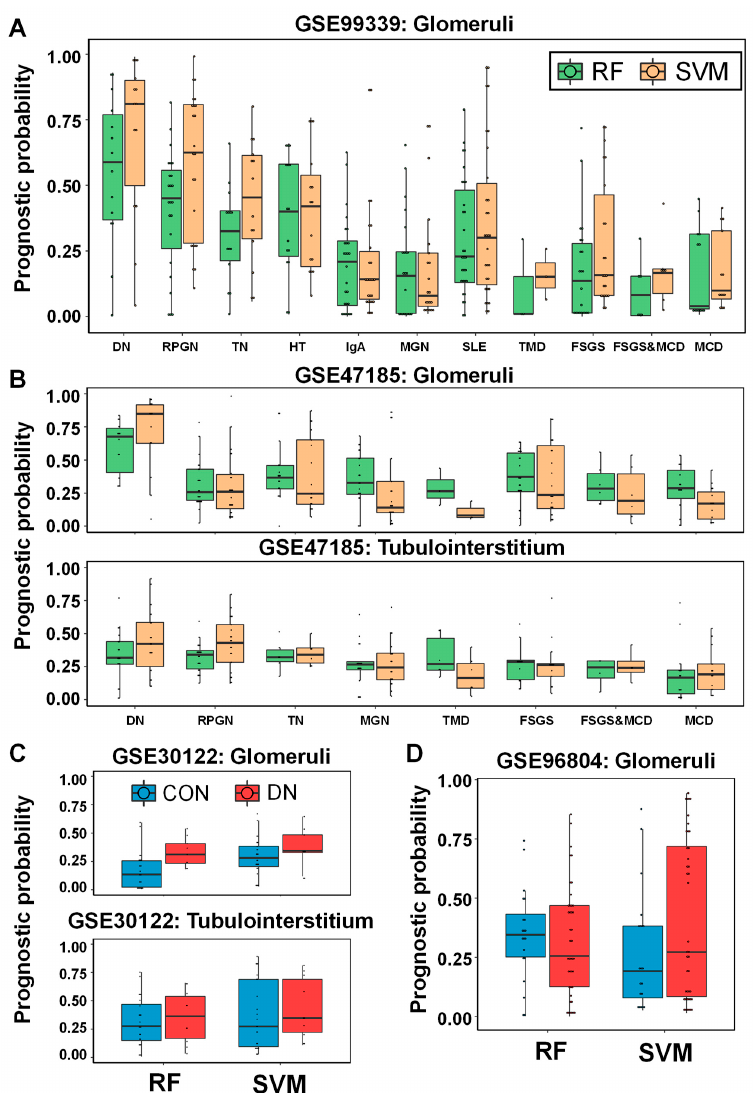
Figure 7. External validation of RF and SVM clinical models in public four GEO datasets (GSE99339, GSE47185, GSE30122 and GSE96804). ( A ) In the GSE99339 dataset, boxplot of the prognostic probabilities of the two classifiers in 11 disease groups including DN ( N = 14), RPGN ( N = 23), TN ( N = 14), HT ( N = 15), IgA nephropathy ( N = 26), MGN ( N = 21), SLE ( N = 30), TMD ( N = 3), FSGS ( N = 22), FSGS&MCD ( N = 6), and MCD ( N = 13). ( B ) In the GSE30122 data set, the prognostic indexes of the two classifiers in the eight disease groups in the renal glomeruli with DN ( N = 14), RPGN, ( N =